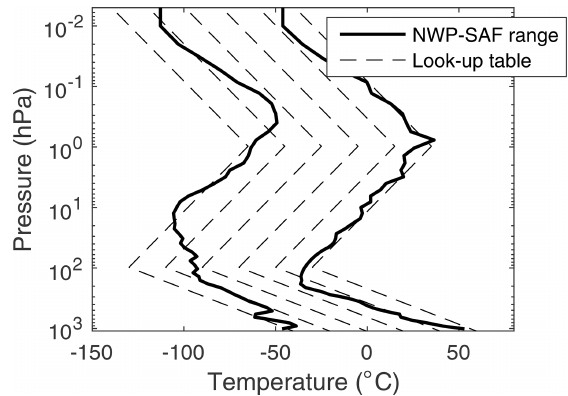
Figure 3. The solid lines show the minimum and maximum temper- atures of the NWP-SAF dataset, also shown in Fig. 1a. The dashed lines show the six idealized temperature profiles, 20K apart, used in the Idealized dataset in Table